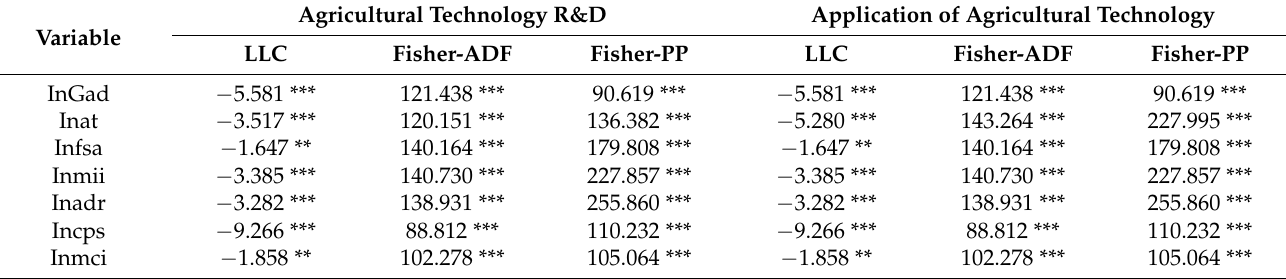
Table 7. Unit root test of each variable.